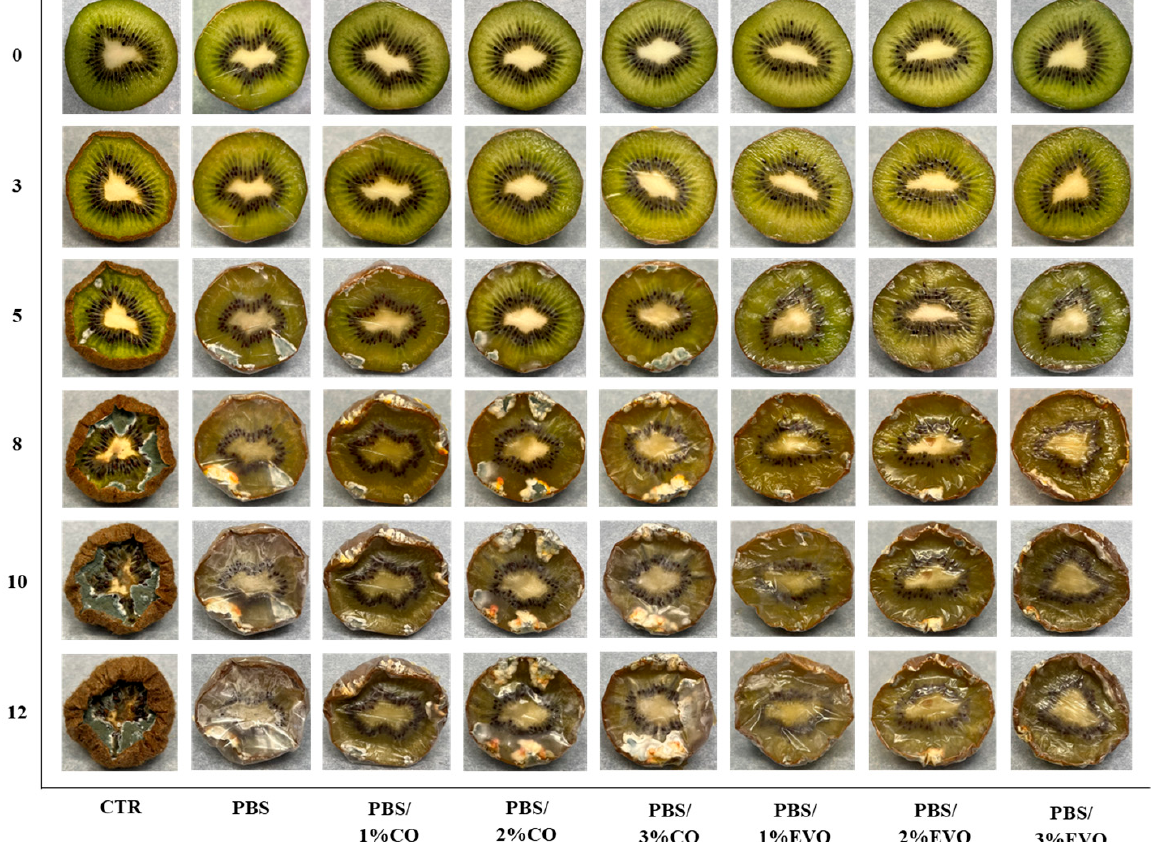
Figure 10. Appearance of fungal growth on sliced apples after 12 days of storage with and without PBS and PBS-based films/formulations stored at room temperature. 4. Discussion After proceeding with the extrusion of all the materials at high temperatures, the use of differential scanning calorimetry (DSC) allowed us to obtain information on the ther- mal behavior of the PBS alone and of those with the addition of olive or coconut oil [17]. It was observed that the melt crystallization temperature ( T mc ) increased. This behavior could be ascribed to the anticipation of the melt crystallization process caused by the oils’